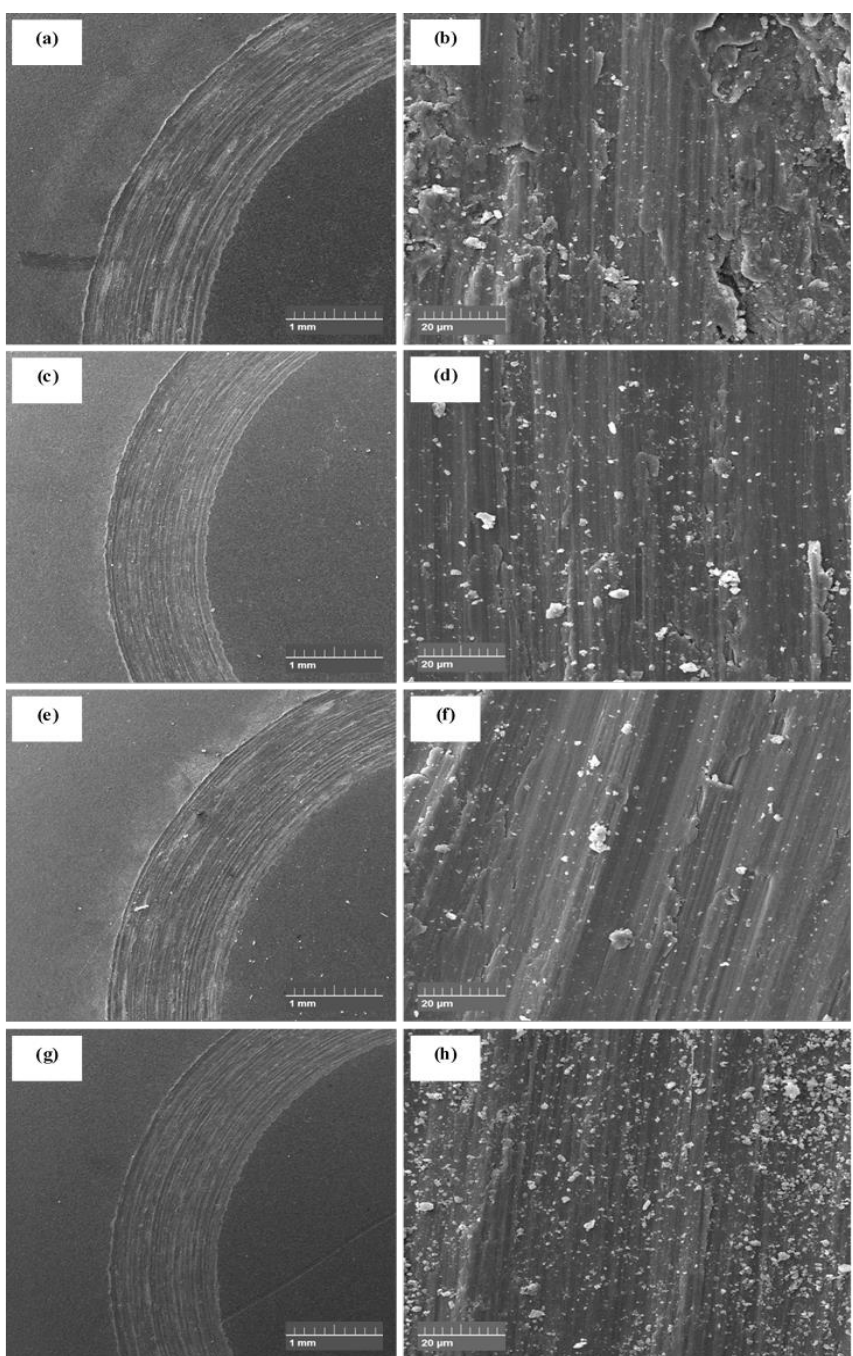
Figure 6. The wear tracks of the PEO coatings ( a , b ) without and with ( c , d ) 1 g/L, ( e , f ) 3 g/L, and ( g , h ) 5 g/L of anatase TiO 2 nanoparticles after the ball-on-disk wear test in SBF solution, viewed at magnifications of 50× and 2000×.